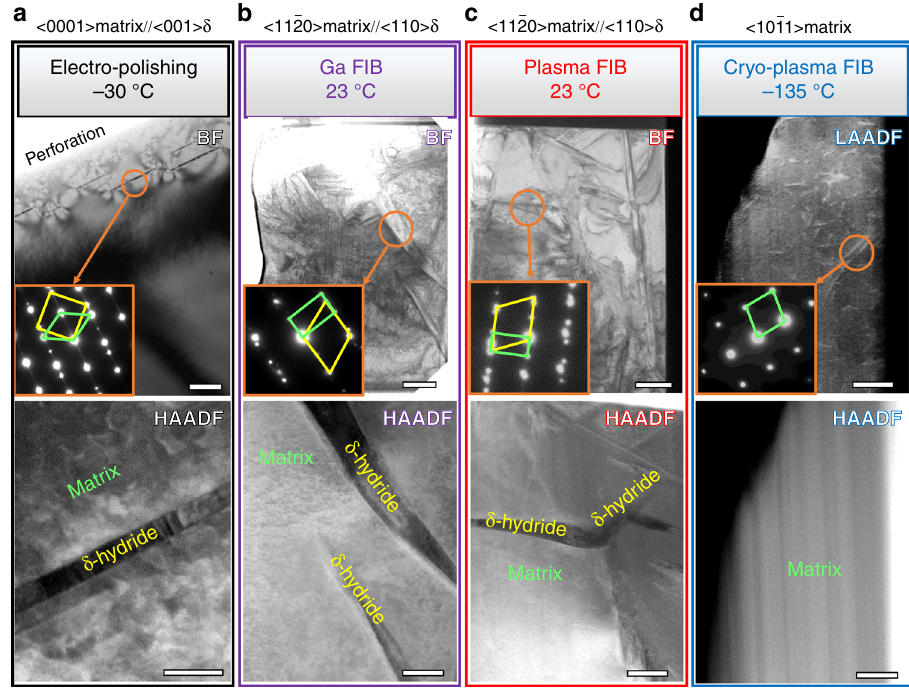
Fig. 1 Transmission electron microscopy characterization. The bright- fi eld TEM, SAED and STEM images for CP Ti prepared by a electro-polishing, b room temperature Ga-FIB, c room temperature Xe plasma FIB (Xe-PFIB) and d cryogenic Xe plasma FIB (cryo-PFIB). The scale bars represent 1 µ m in the BF and 50 nm in the HAADF ( a ), 1 µ m in the BF and 500 nm in the HAADF in ( b , c ), 500 nm in both the BF and the HAADF in ( d ). The inserts show the corresponding SAEDs indicating that the electron beam was close to the <0001> α , <112 ̄ 0> α , <112 ̄ 0> α and <101 ̄ 1> α zone axes for ( a ), ( b ), ( c ) and ( d ), respectively. Zone lines of each set of images are shown on top. The yellow and green lines in the insert SAEDs correspond to the diffraction re fl ections of δ -hydride and matrix, respectively. TEM transmission electron microscopy, SAED selected area electron diffraction, STEM scanning transmission electron microscopy, FIB focussed ion beam, HAADF high-angle annular dark fi